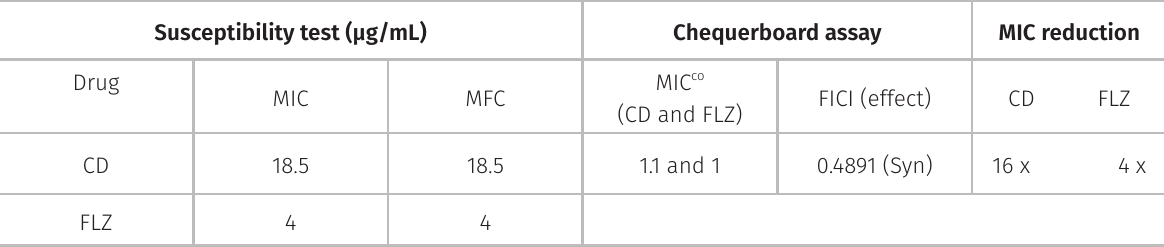
Table I. Susceptibility assay duloxetine hydrochloride (DH) alone or in combination with fluconazole against C. neoformans